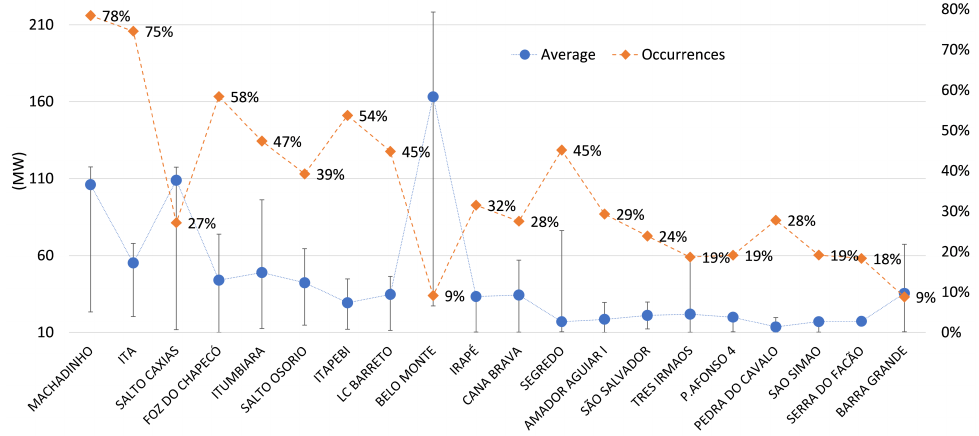
Figure 8. The 20 plants with most violations over all cases and trials. The blue line shows the average of violations greater than 10 MW. The error bar of this line extends from the minimum violation (greater than 10 MW), to the maximum. The orange line shows the percentage of time periods when there are violations greater than 10